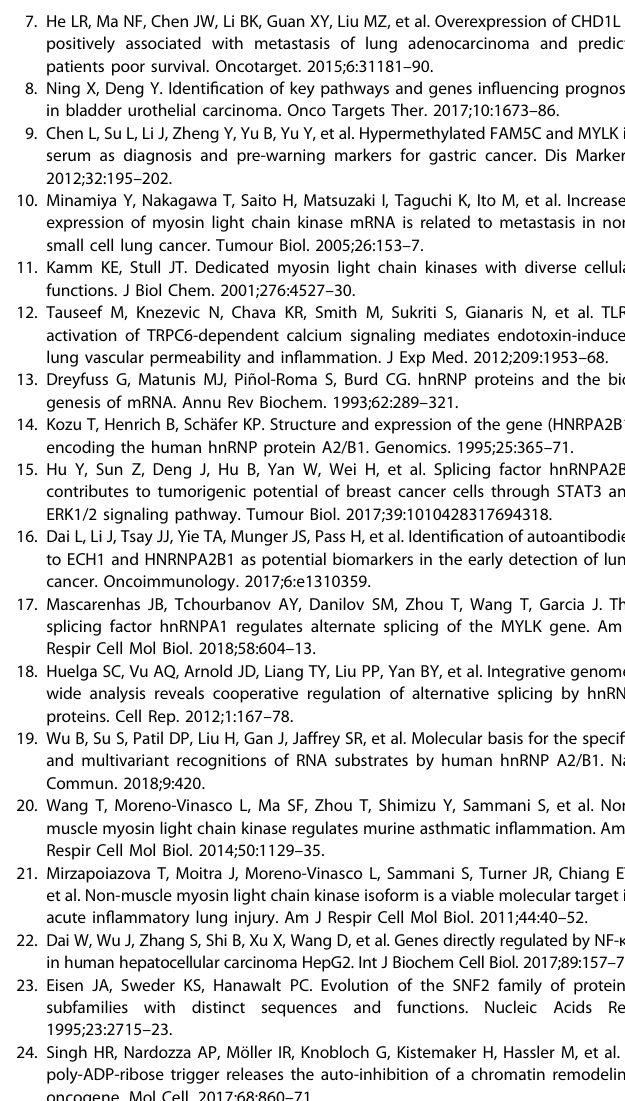
Fig. 7 Schematic diagram depicts a proposed model for the regulation and mechanism of nmMYLK in HCC. CHD1L upregulates hnRNPA2/ B1 to promise the nmMYLK formation. Abundant nmMYLK might interact with MyD88 and IRAK4 to activate NF- κ B and its downstream signaling, which fi nally promoting the proliferation of tumor cells. The Depleted nmMYLK enable MyD88 to interact with Caspase-8 and lead to the cascade activation reaction of caspase proteins, which fi nally result in tumor cell